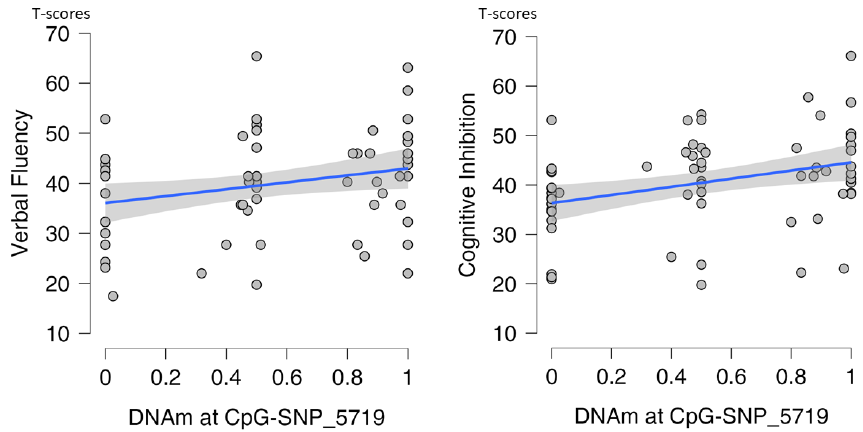
Figure 3. Relations of DNA methylation (DNAm) at CpG-SNP_5719 with cognitive phenotypes in patients. Regression lines (blue) with 95% CI (grey shaded areas) are shown.